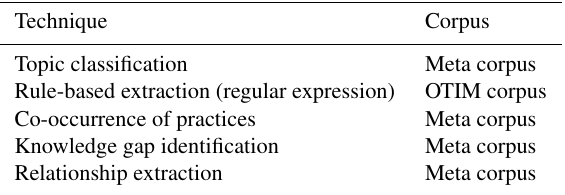
Table 1. Overview of NLP techniques used and corpus